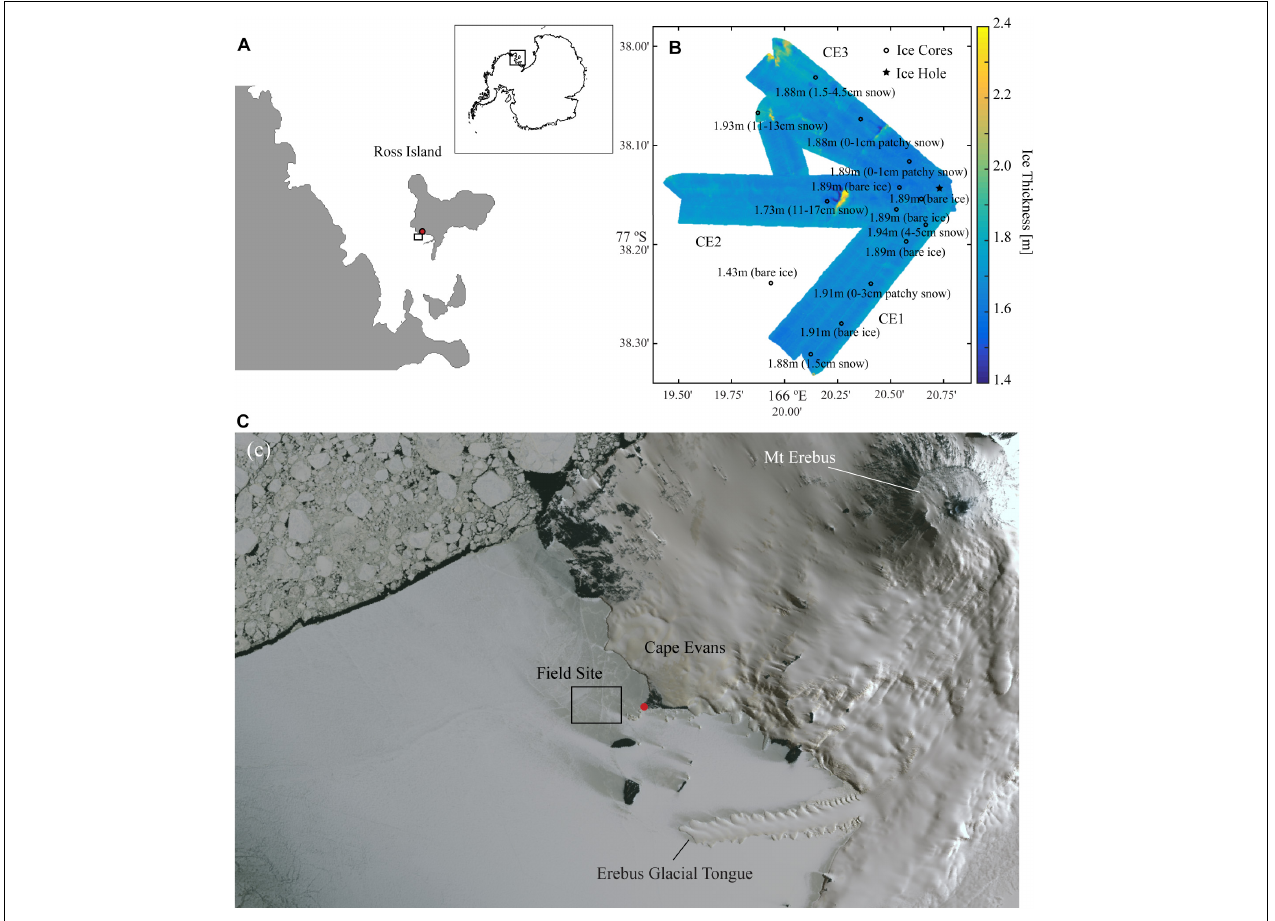
FIGURE 1 | (A) Location of Cape Evans, McMurdo Sound within the Antarctic continent (inset); (B) Ice thickness as mapped across 60 m swaths using the interferometric Geoswath plus sonar onboard the AUV on the three transects where spectral irradiance measurements were made (CE1, CE2, and CE3) with point measurements of ice thicknesses and snow condition measured at each of the coring stations (open circle) in addition to the ice hole (filled star) from which the vehicle was deployed; and (C) a WorldView-1 satellite image collected on 2 November 2014 showing the snow coverage in the region around Cape Evans and the location of the main field camp (red